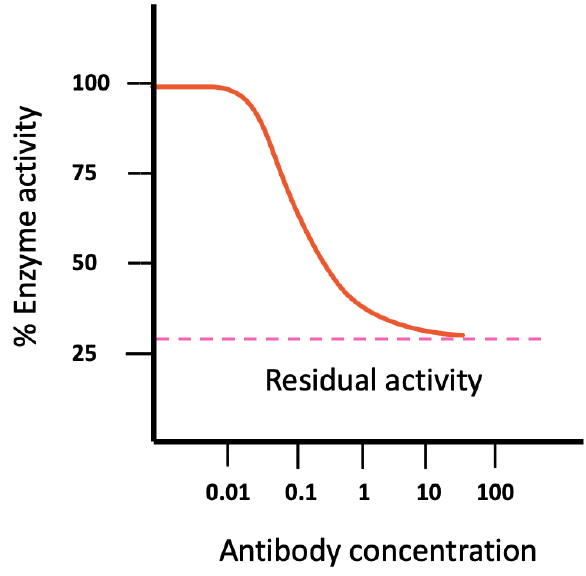
Figure 1 : Kinetic of the interaction between enzyme and antibody showing a decrease in enzymatic activity with increasing concentration of antibody. The residual catalytic activity of the enzyme is typically found in excess of